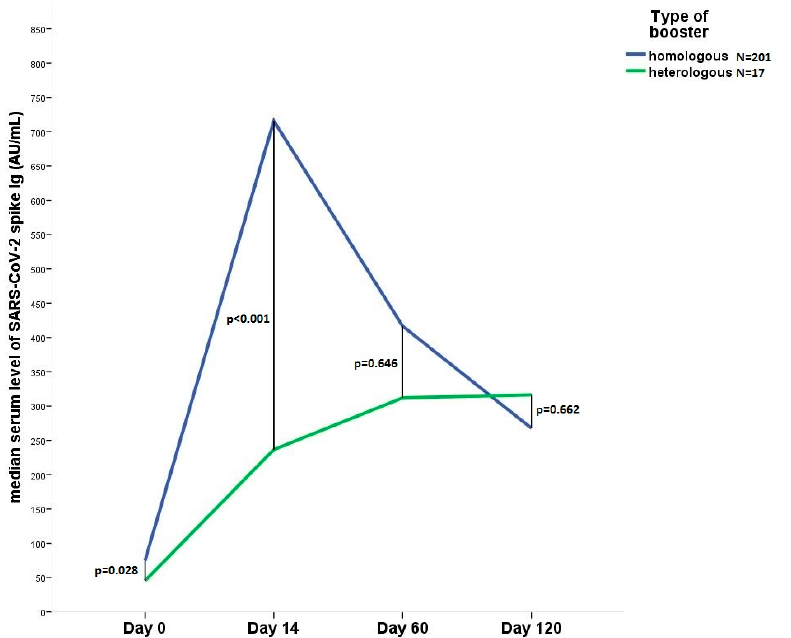
Figure 1. Line diagram shows the change in the median anti SARS-CoV-2 IgG level 14, 60 and 120 days